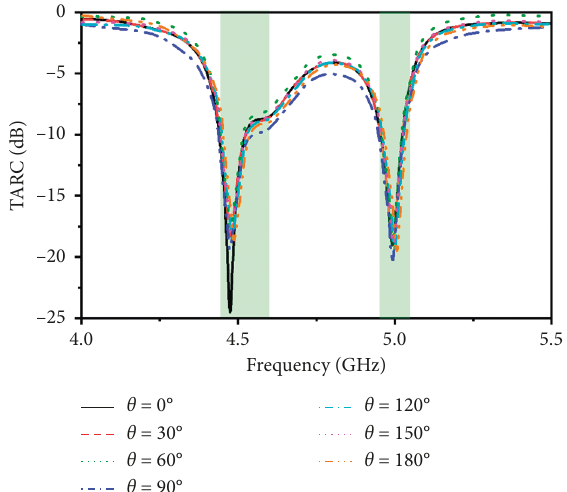
Figure 13: Proposed MIMO antenna TARC.